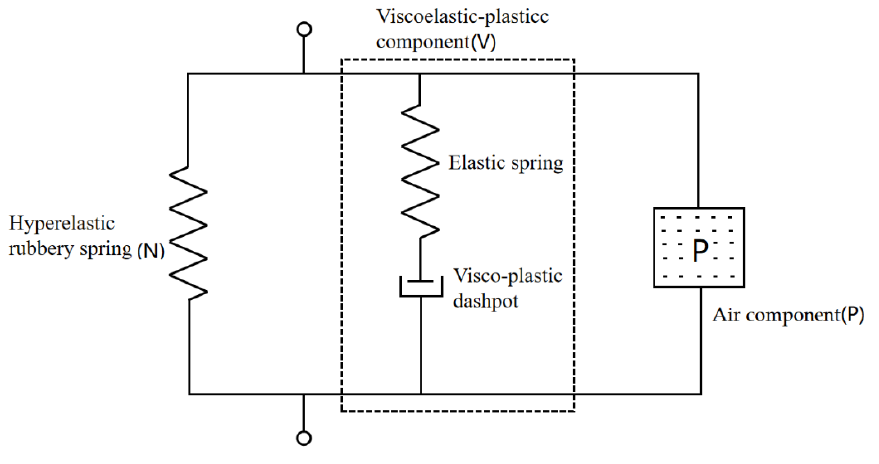
Figure 15. One-dimensional diagram of constitutive model.